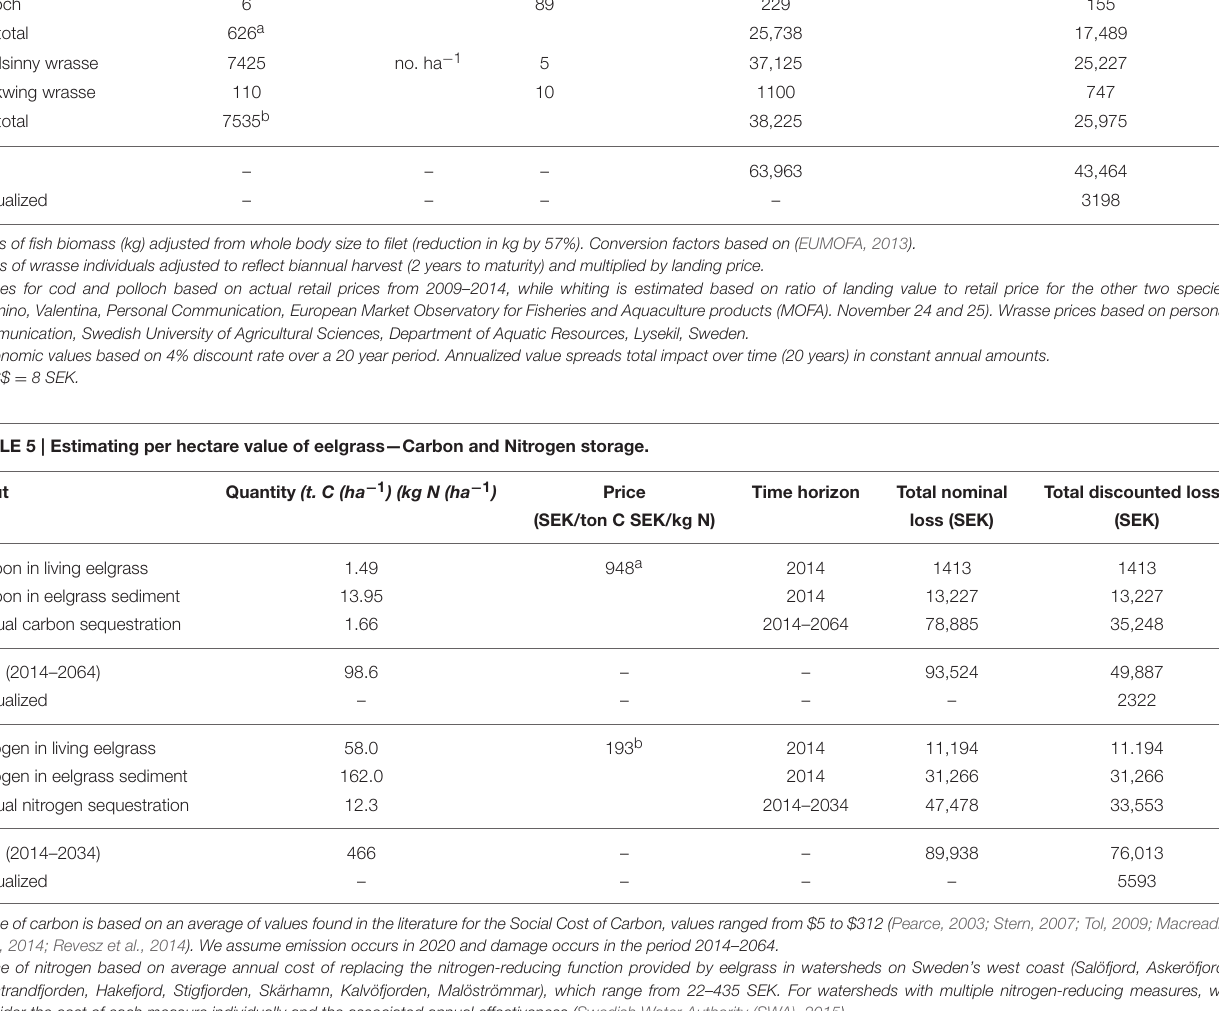
Nitrogen in living